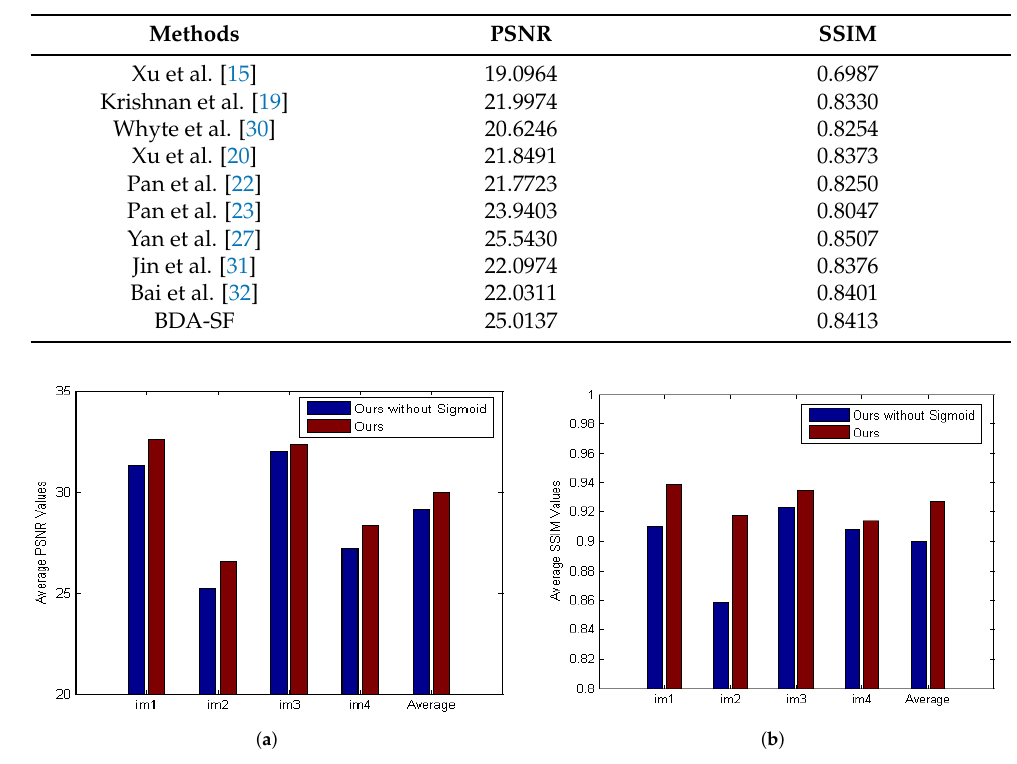
Table 2. Quantitative evaluations on the image from Figure 12.